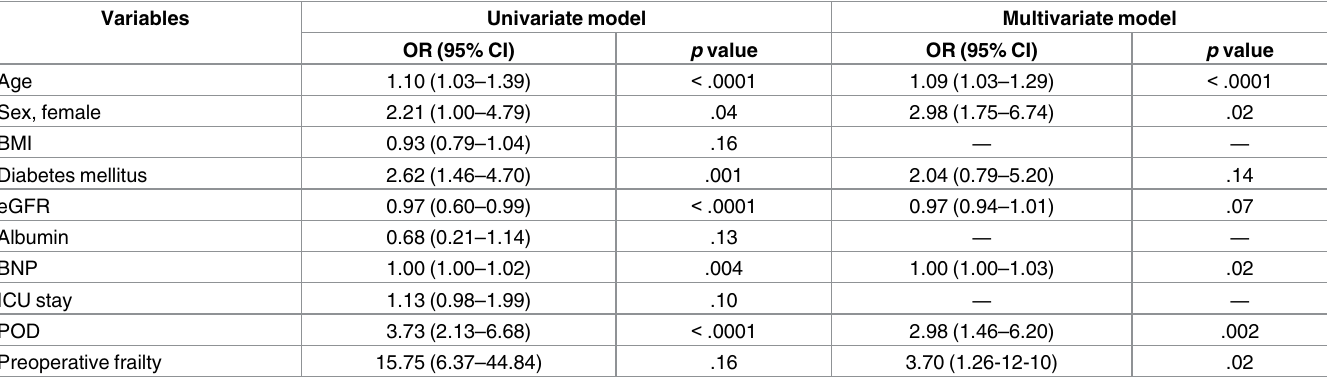
Table 4. Univariate and multivariate analysis of risk factors for postoperative